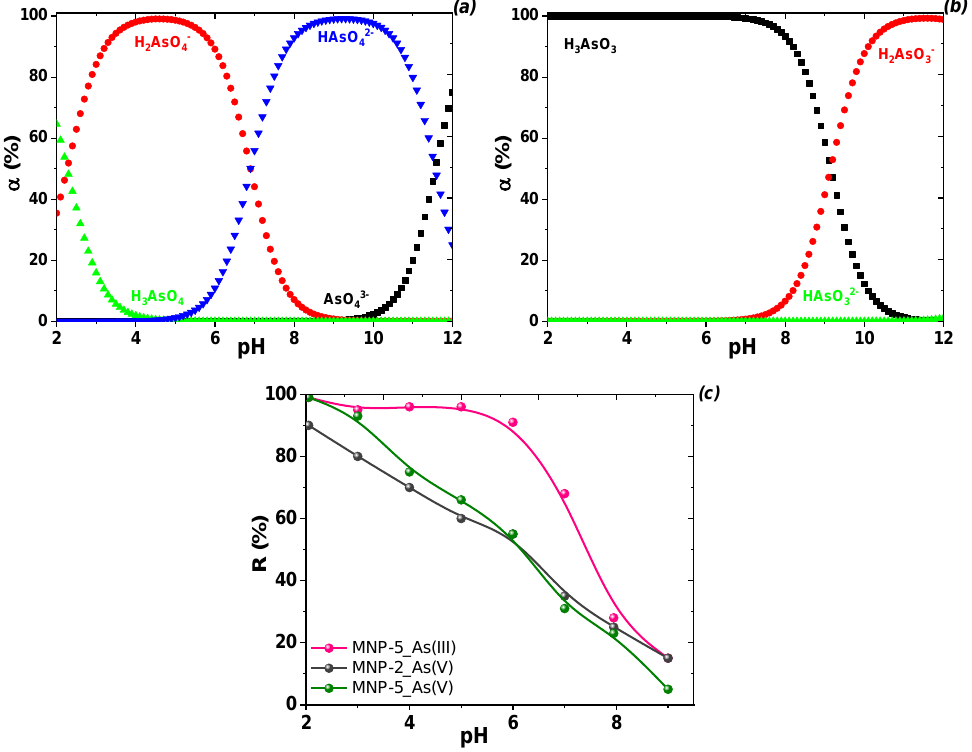
Figure 8. Effect of pH on arsenate ( a ) and arsenite ( b ) speciations in aqueous solution and their removal by selected samples (MNP-2 and MNP-5) ( c ) (conditions: C 0 (As(V)), 2 mg/L; treated volume, 10 mL; adsorbent dosage: 30 mg; treatment time, 2 h at room temperature).